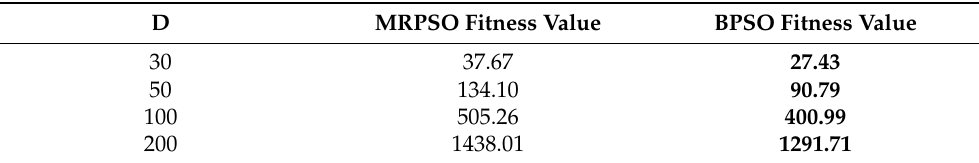
Table 17. Mean of the particle best-fit values in MRPSO and BPSO on f 4 . The bold numbers refers to the better